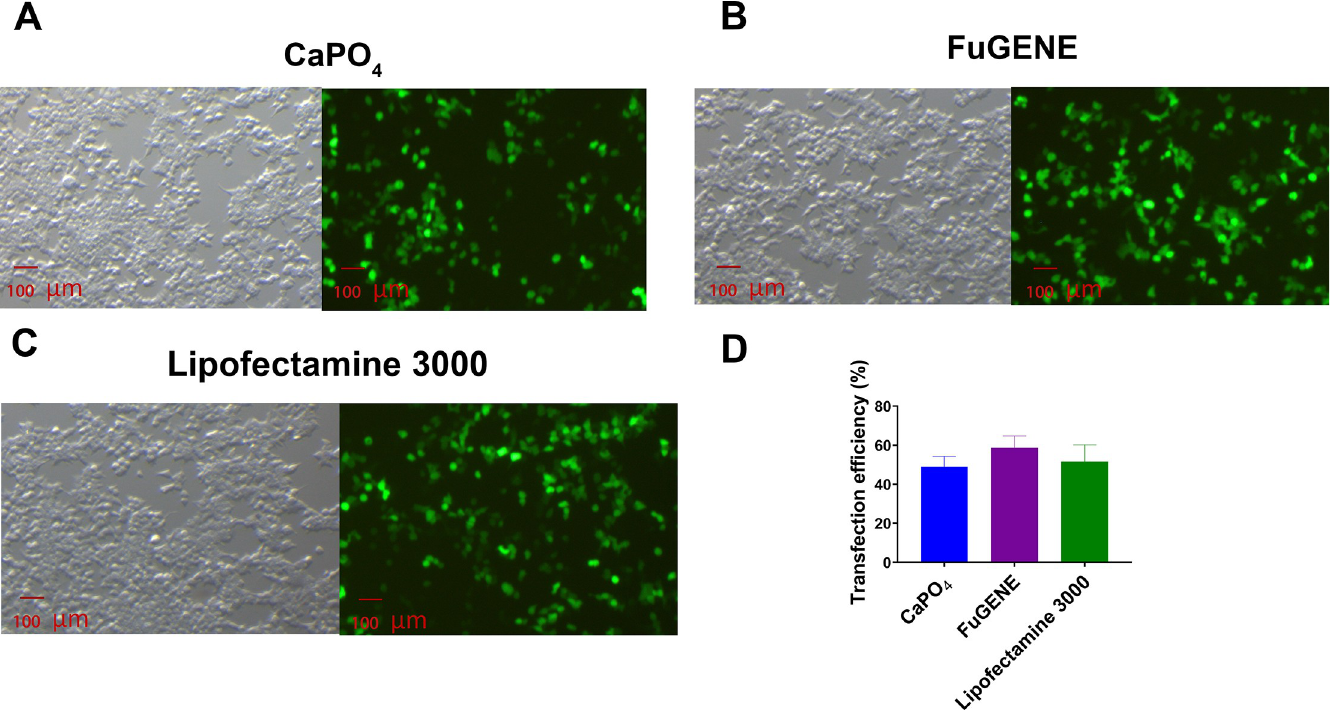
Fig 3. eGFP-visualized transfection. Fluorescence images of HEK 293T cells co-transfected with eGFP together with Ca V 2.2 subunits ( α 1B , α 2 δ 1 and β 1 ) cDNA using (A) calcium phosphate, (B) FuGENE or (C) Lipofectamine 3000 was used to monitor transfection efficiency. (D) The transfection efficiency of the calcium phosphate-, FuGENE- and Lipofectamine 3000-mediated transfection was 49.0 ± 3.1%, 58.7 ± 3.5% and 51.7 ± 4.9%, respectively. Data are represented as mean ± SEM (N = 3 independent experiments conducted in triplicate).